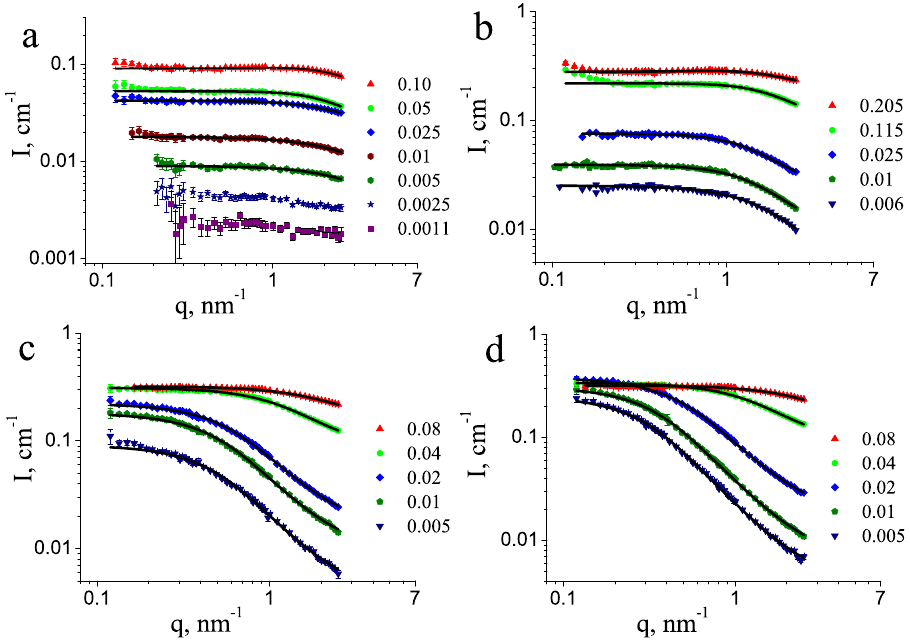
Figure 1. SANS curves for heavy water solutions of PEG of molecular mass ( a ) 0.4 kDa, ( b ) 1 kDa, ( c ) 10 kDa, ( d ) 20 kDa. Solid lines show the model fitting according to equations (1) and (2). The mass fractions of PEG are indicated.